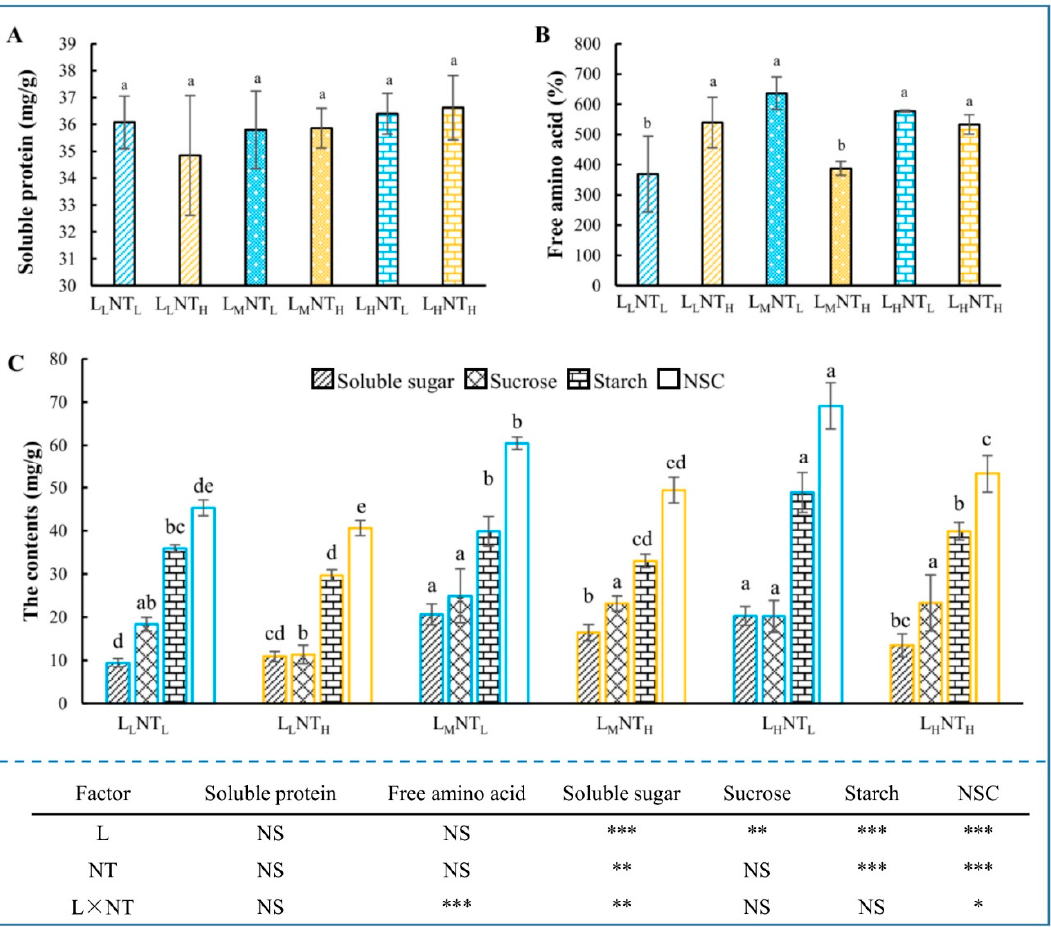
Figure 6. Effect of light intensity (LI) and night temperature (NT) on the carbon and nitrogen nutrition status including soluble protein ( A ), free amino acid ( B ) and sugar ( C ) contents of cherry tomato seedlings. NSC, non-structural carbohydrates. Abbreviations of different treatments were as described in Figure 1. The symbol “NS”, “*”, “**” and “***” indicate no significance at p < 0.05, significant level at p < 0.05, p < 0.01 and p < 0.001 by Duncan’s test, respectively. Different letters on bars for the same parameter indicate statistically significant differences ( p < 0.05).